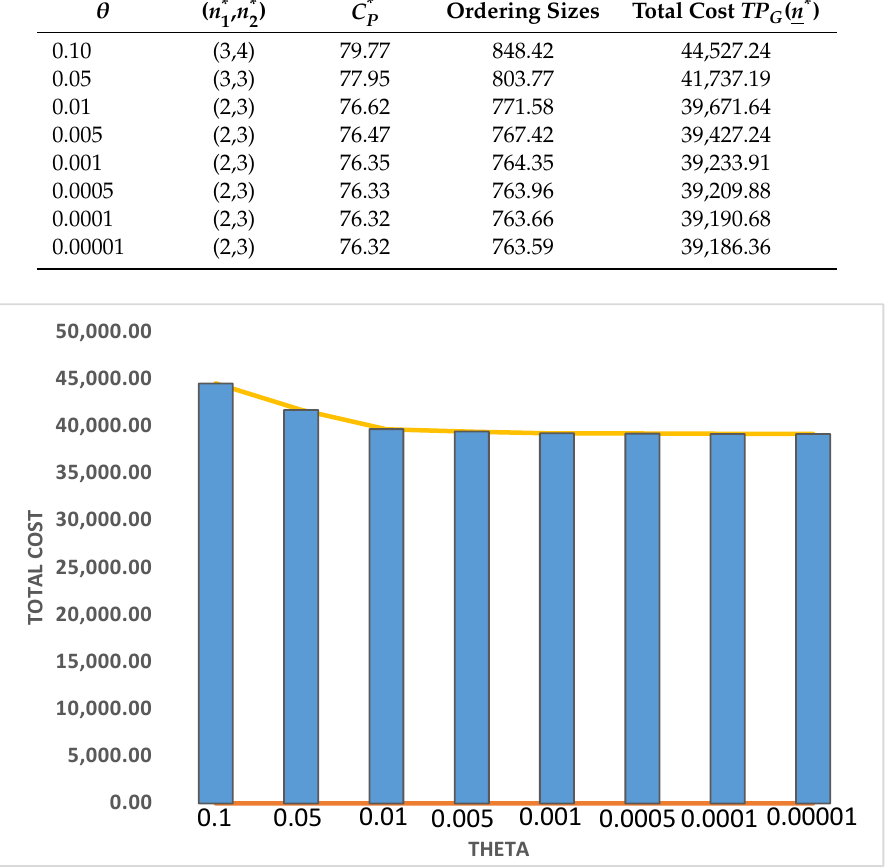
Figure 3. Total cost for various deterioration rates.